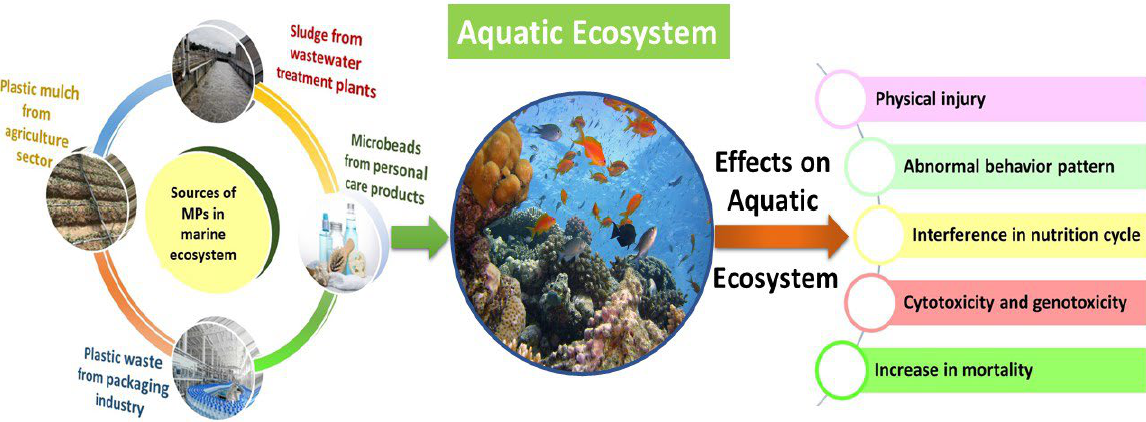
Figure 12. An overview of sources and toxic effects of MPs on aquatic environment